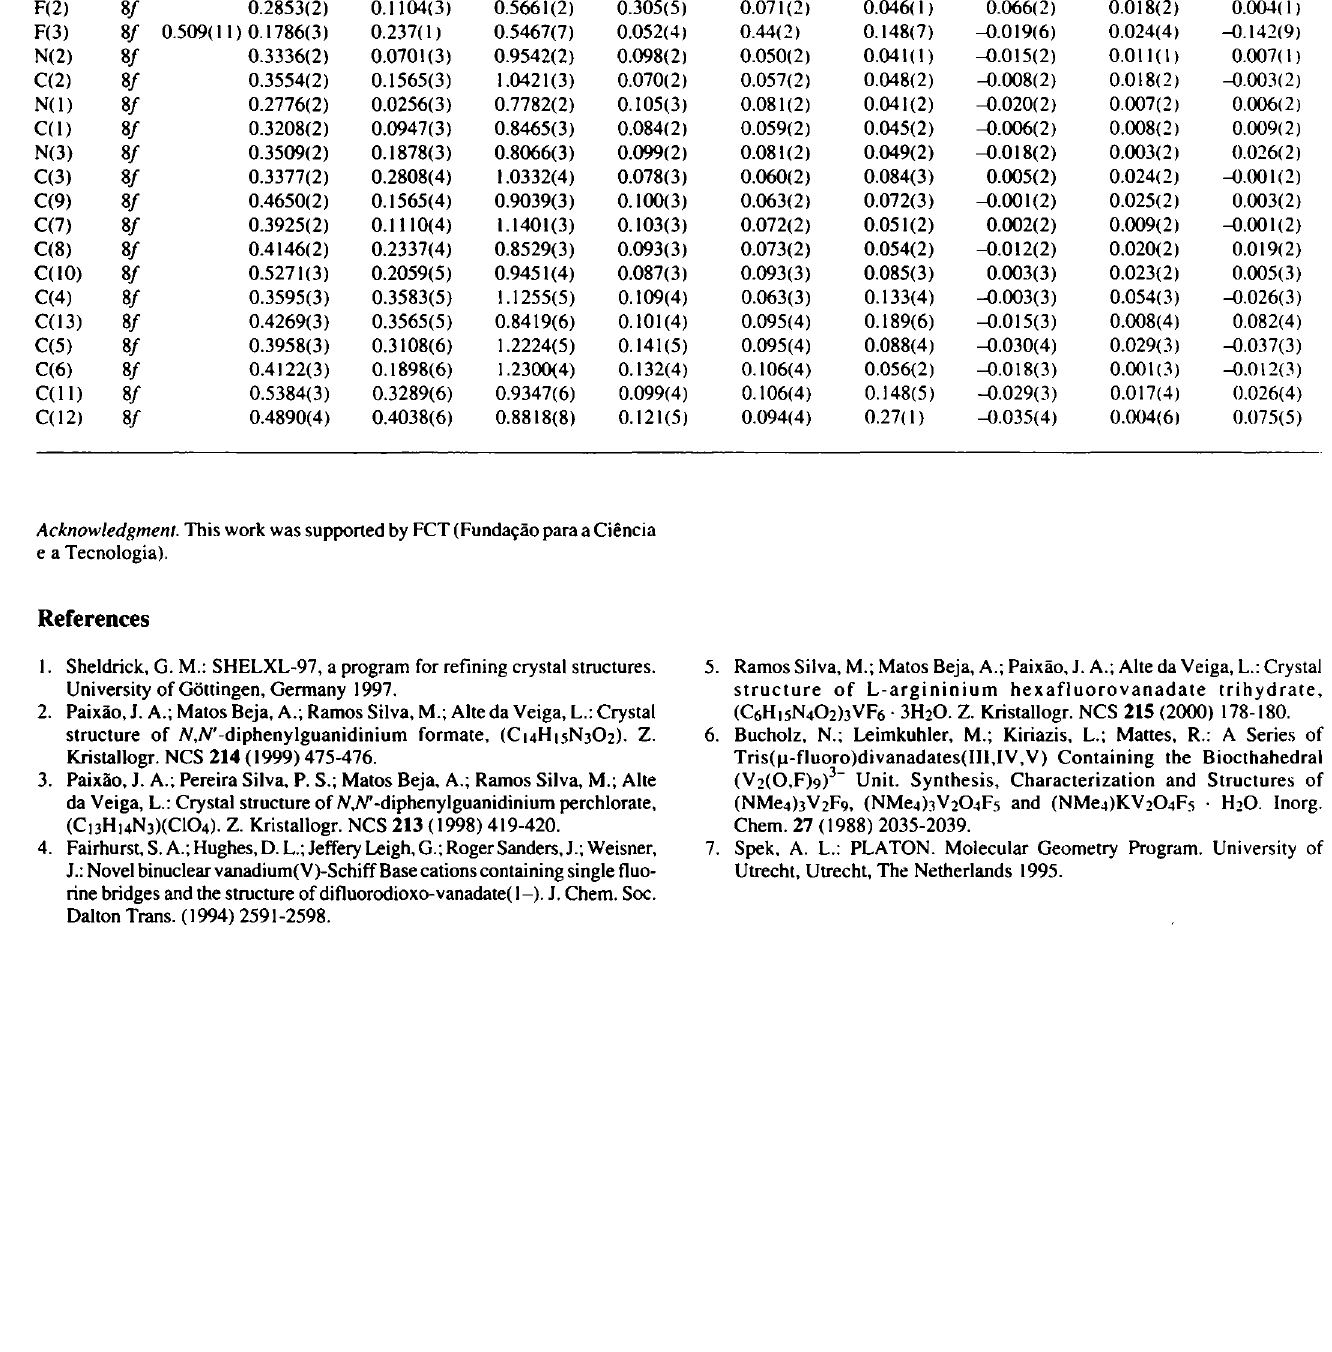
Table 3. Atomic coordinates and displacement parameters (in Ä